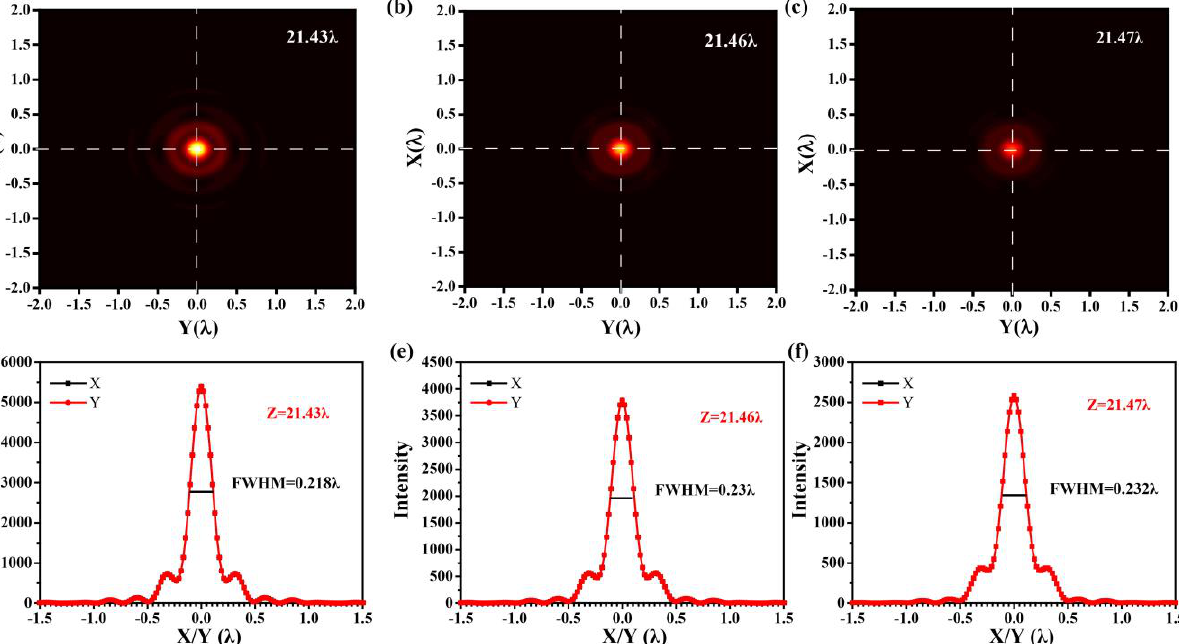
Figure 3. The characterization of the propagation of the solid immersion lens. ( a ) Intensity distribution of light beam along the propagation direction. ( b ) Numerical simulation (red line) and FDTD simulation (blue line) of the intensity distribution curve of the electric field.